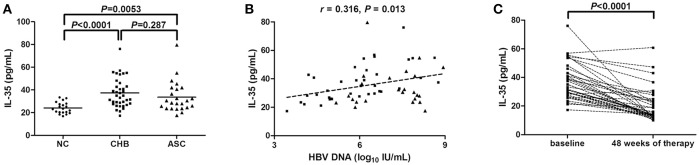
Interleukin (IL)-35 expression in patients with chronic hepatitis B virus (HBV) infection. (A) The concentration of IL-35 in the serum was measured by enzyme-linked imunosorbent assay (ELISA) in normal controls (NCs, n = 20), patients with chronic hepatitis B (CHB, n = 37), and asymptomatic HBV carriers (ASC, n = 24). Horizontal bars indicate mean value of each subset, and the individual level for each subject is shown. Significances were calculated using SNK-q test. (B) Pearson correlation analysis of IL-35 concentration with HBV DNA in 61 patients with chronic HBV infection (including CHB and ASC). (C) IL-35 concentration in the serum was also measured by ELISA in CHB patients receiving 48-week of entecavir therapy. The individual level for each subject is shown. Significance between baseline and 48 weeks post-therapy was calculated using paired t-test.